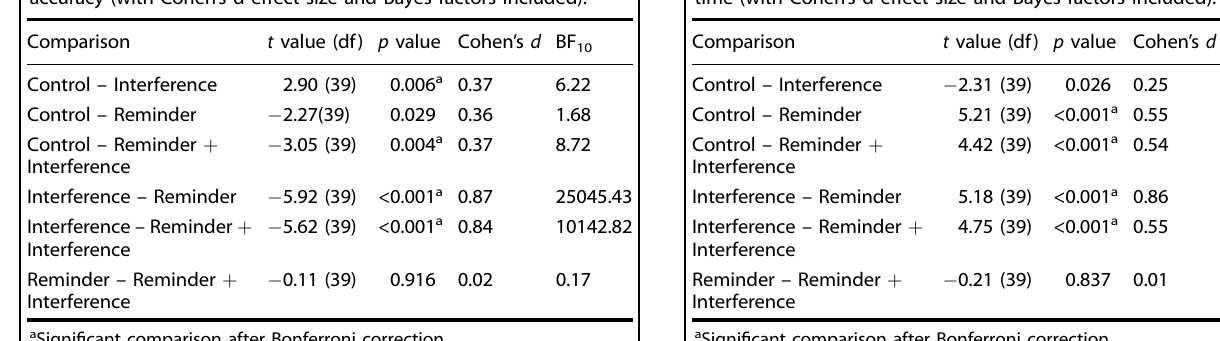
Table 2. Simple effects analyses comparing conditions on reaction time (with Cohen ’ s d effect size and Bayes factors included).